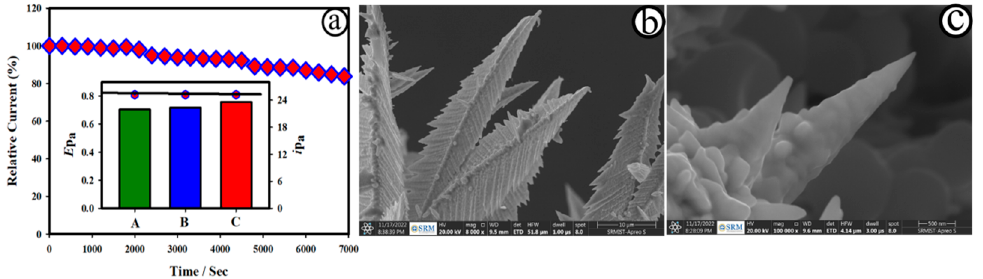
Figure 7. ( a ) Plot of relative catalytic activity of NO oxidation against time for the AuNC@AuDS|CF microelectrodes in 10 µM NO 2 − + 0.1M PB for 7000 sec ( E app : 0.8 V). (Inset) Plot of the catalytic activity of three brand-new AuNC@AuDS|CF microelectrodes recorded for 50 µM NO 2 − 0.1M PB, derived from Figure S8. ( b , c ) FE-SEM images of AuNC@AuDS|CF microelectrodes after a stability test in real serum samples.